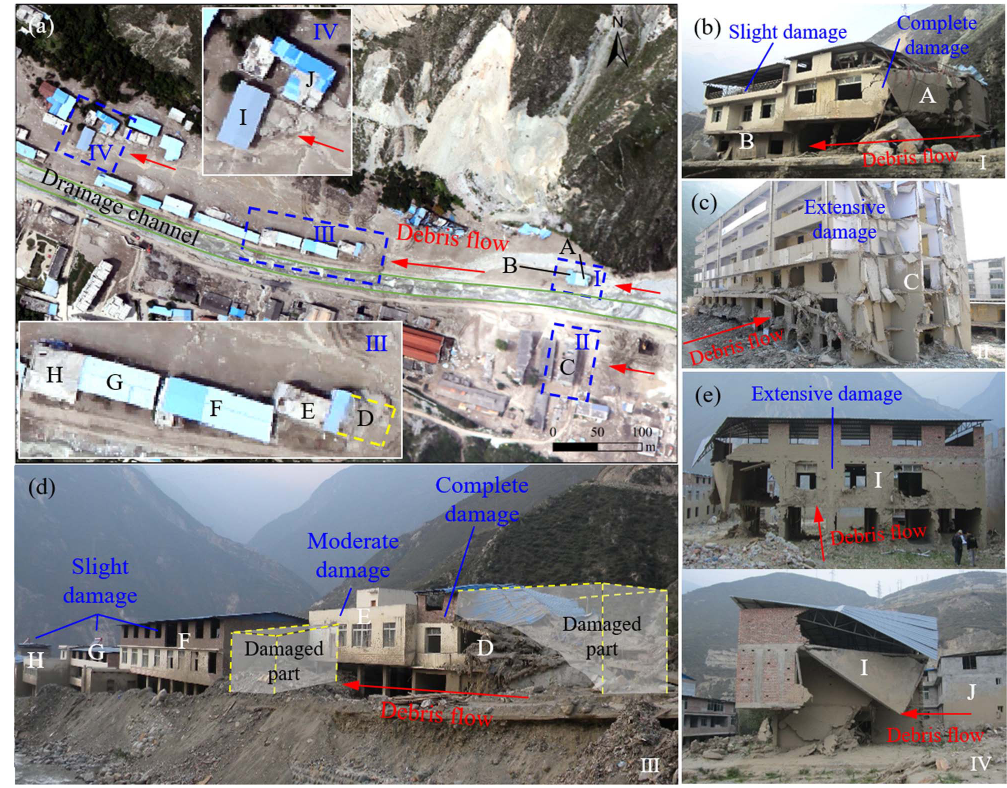
Figure 8. Distribution of damaged buildings in the Qipan gully debris flow event. Orthophoto map is from the Basic Geographic Information Center of the province of Sichuan, China, 21 July 2013.